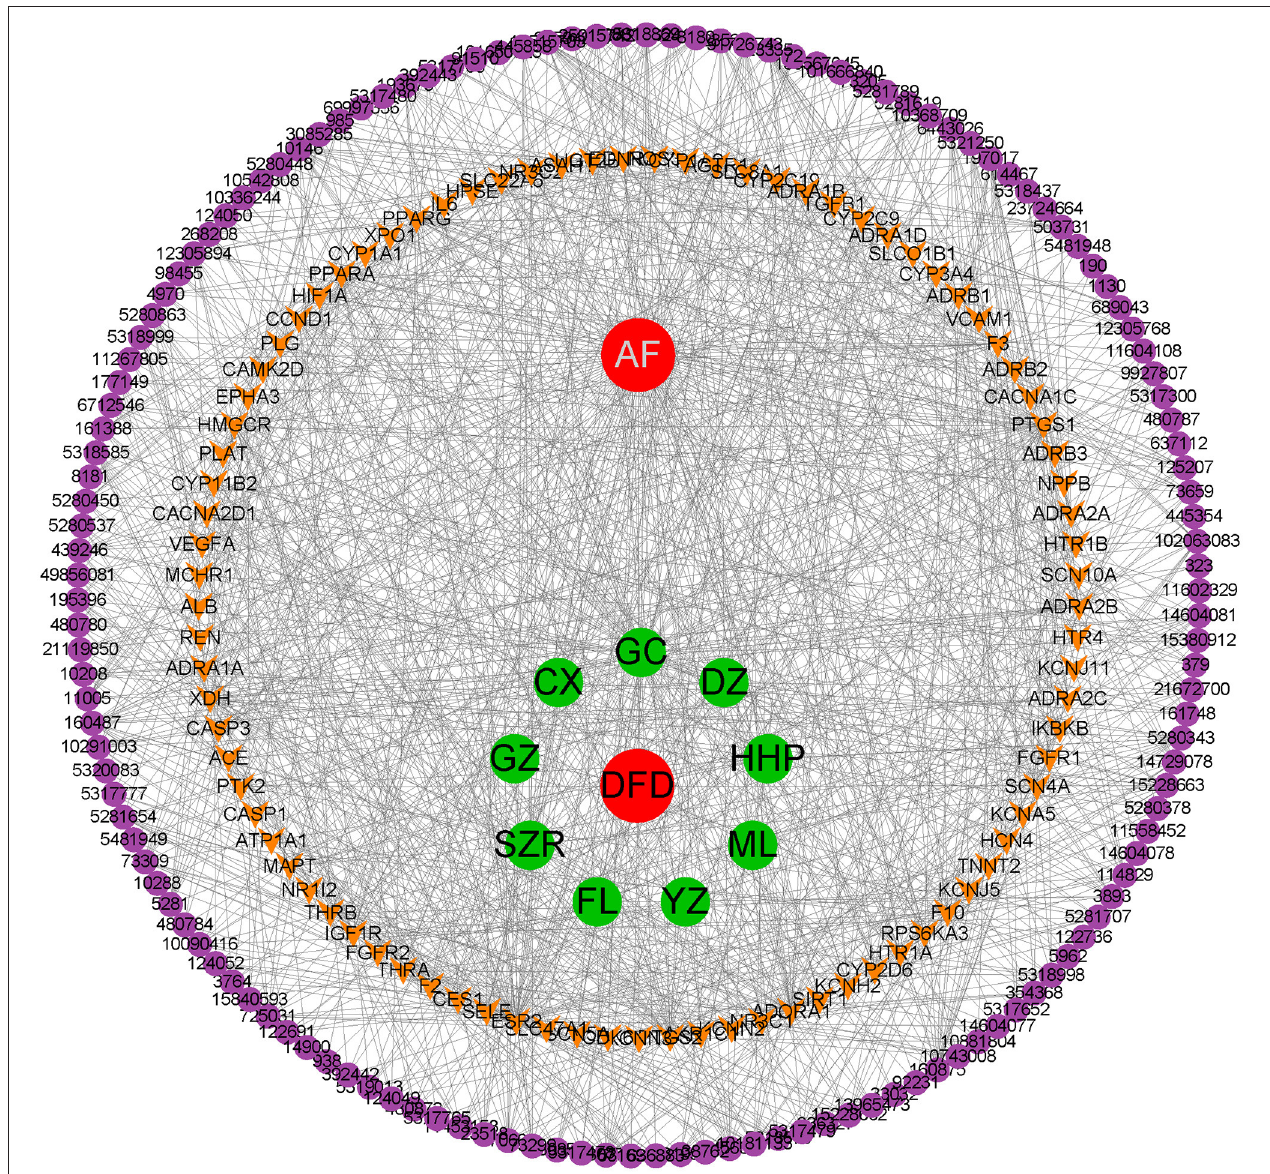
FIGURE 2 | The H-C-T-D